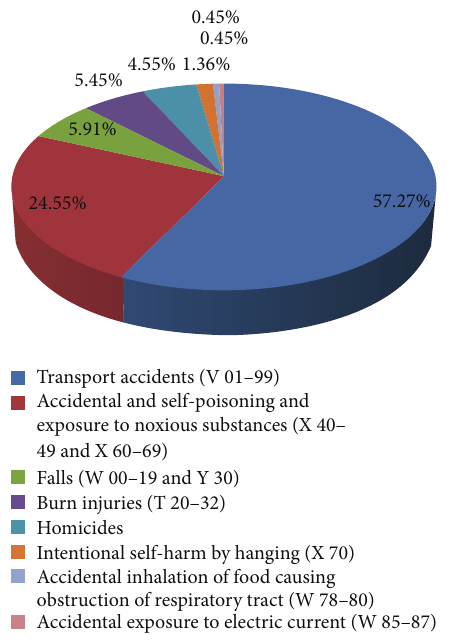
Figure 2: Distribution of unnatural causes of death among 50+ population.